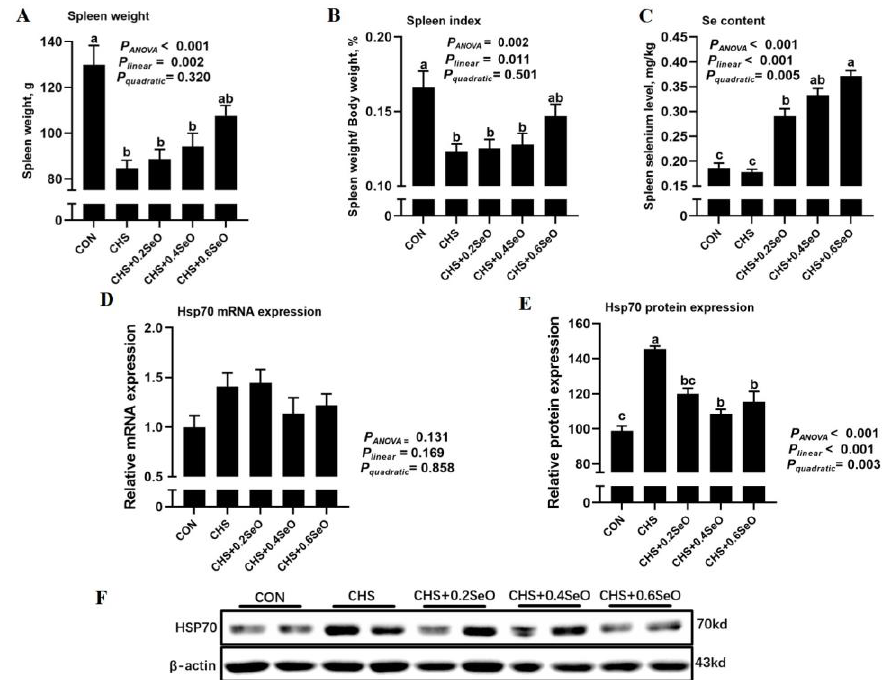
Figure 1. Effects of CHS and SeO supplementation on spleen weight ( A ), spleen weight/body weight ( B ), spleen Se concentration ( C ), mRNA ( D ) and protein ( E , F ) expression of HSP70 in the spleen of growing pigs. The results were expressed as mean ± SEM ( n = 6). Different letters (a, b and c) denote significant differences, P ANOVA : p value of Analysis of Variance, P linear and P quadratic : p value of Orthogonal Polynomial Contrasts.